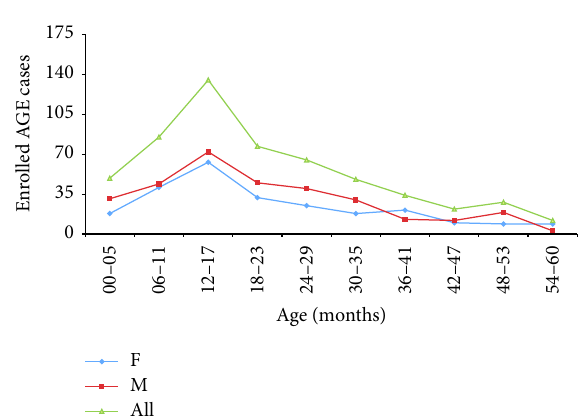
Figure 1: Age distribution of the cohort of children with